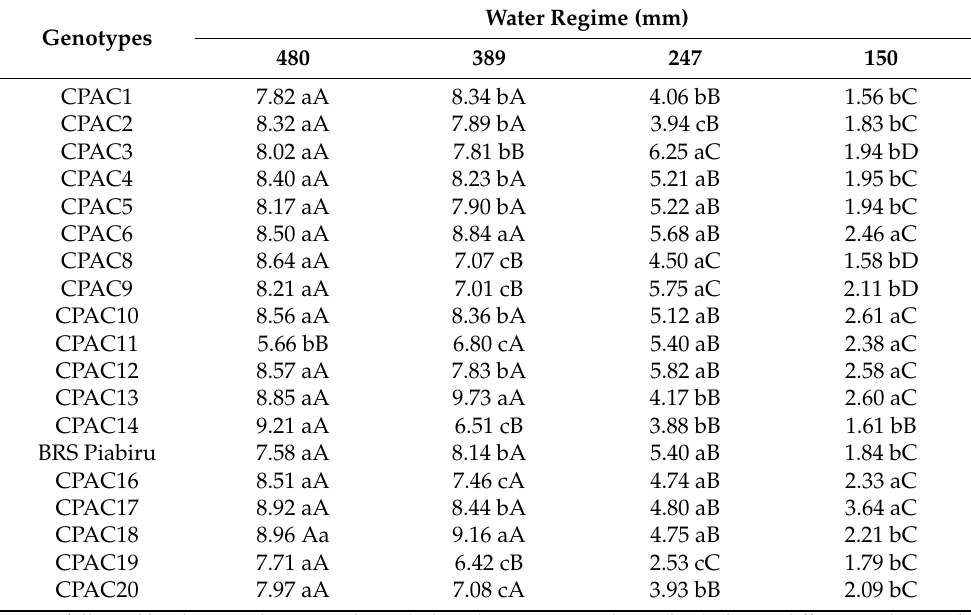
Table 1. Productivity (t ha − 1 ) of 18 quinoa genotypes and BRS Piabiru under 4 water regimes. Water Regime (mm) Genotypes 480